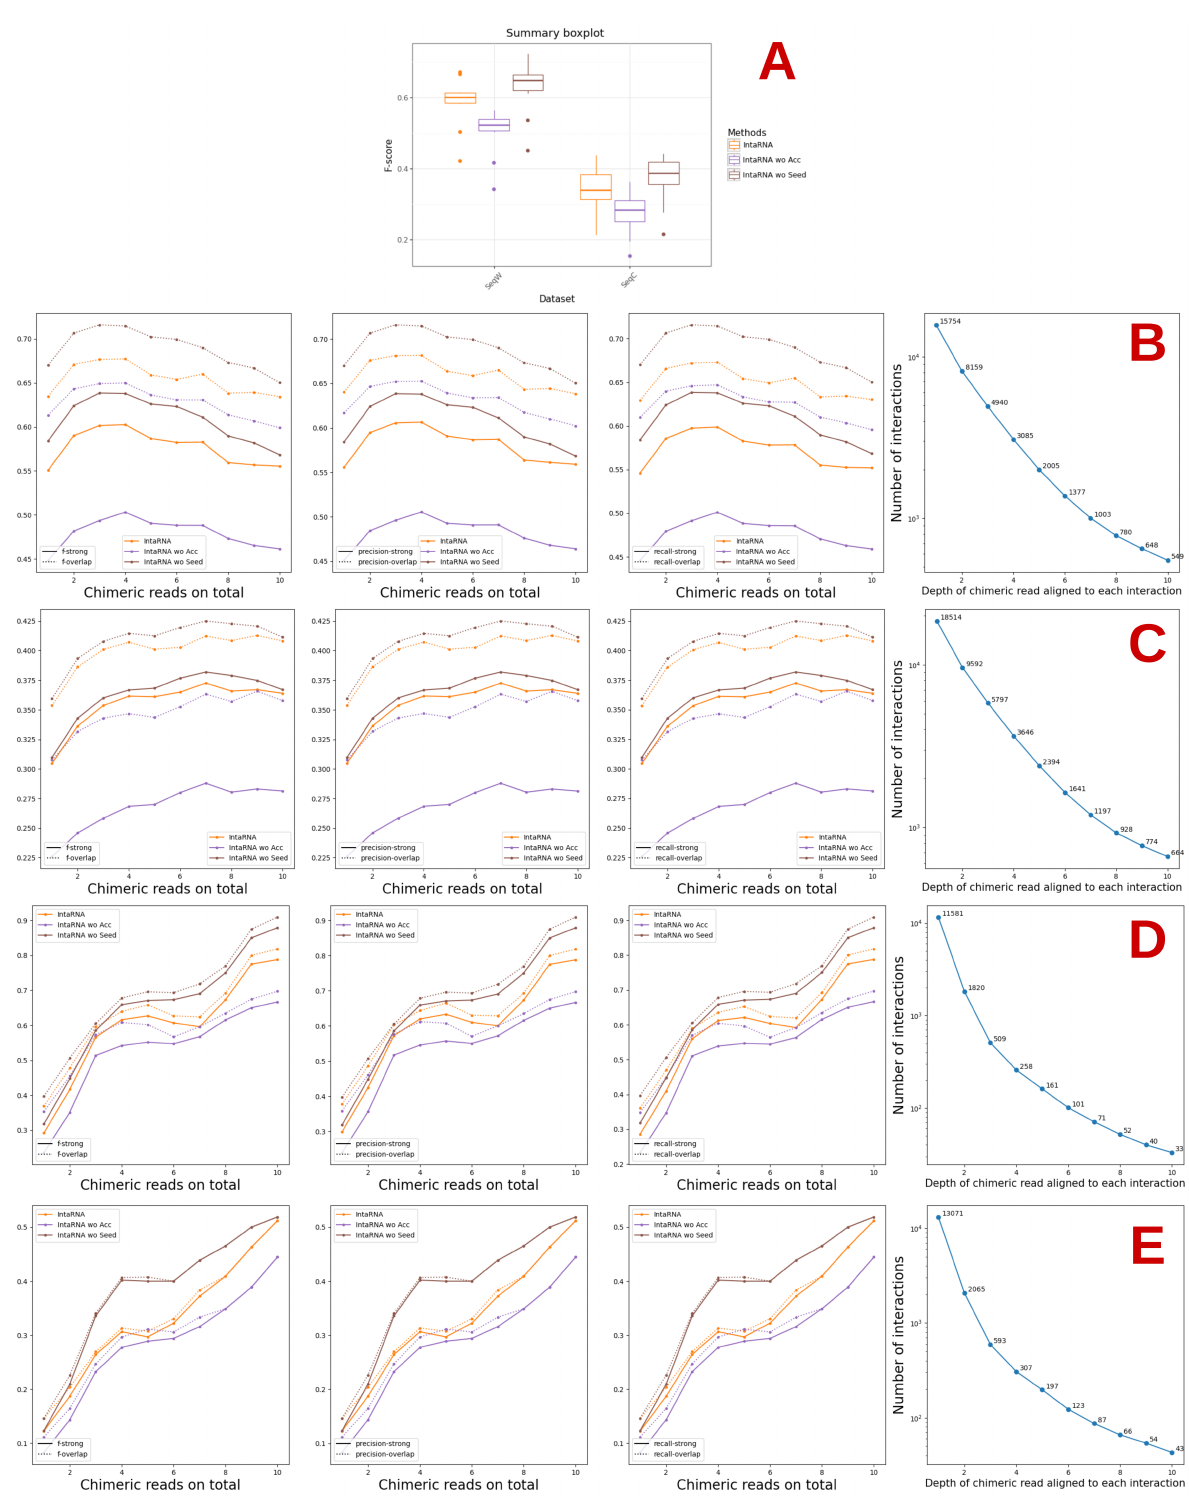
Figure 3. Performance of I NTA RNA considering or not accessibility and seed match. The term wo in the Figure stands for WithOut. ( A ) summarises the results of the combined human and mouse datasets. ( B , C ) and, resp., ( D , E ) show the results on the Seq W and Seq C human, resp. mouse,